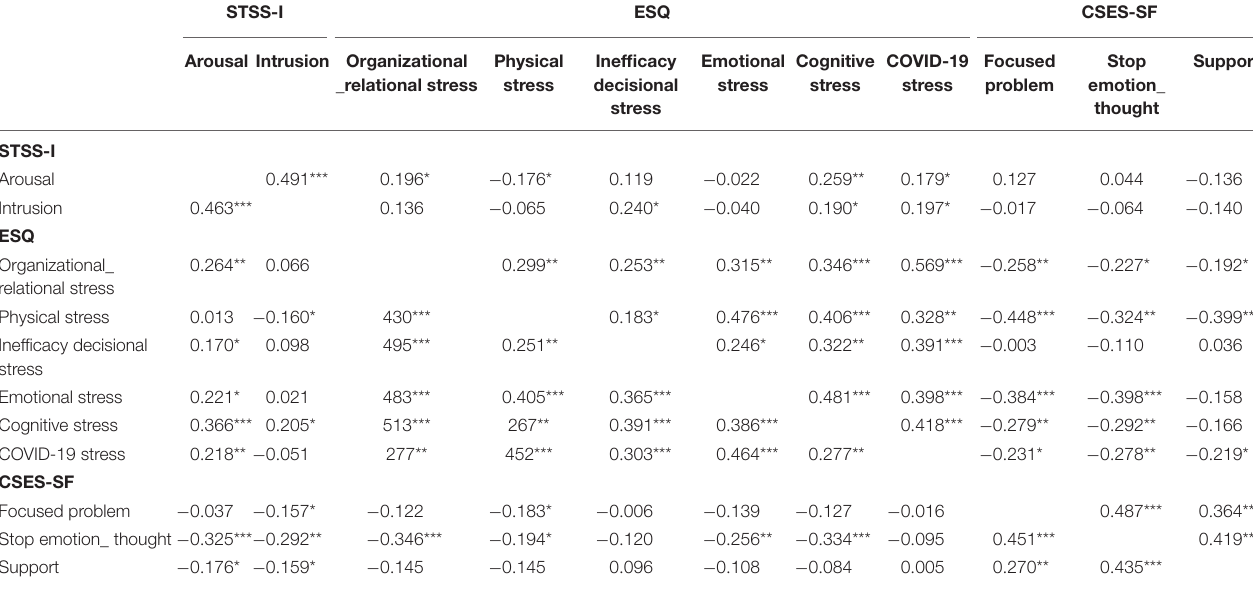
TABLE 1 | Intercorrelations of STSS-I, ESQ, and CSES-SF for Health (above diagonal), and Emergency (below diagonal) Groups ( n = 210). STSS-I ESQ